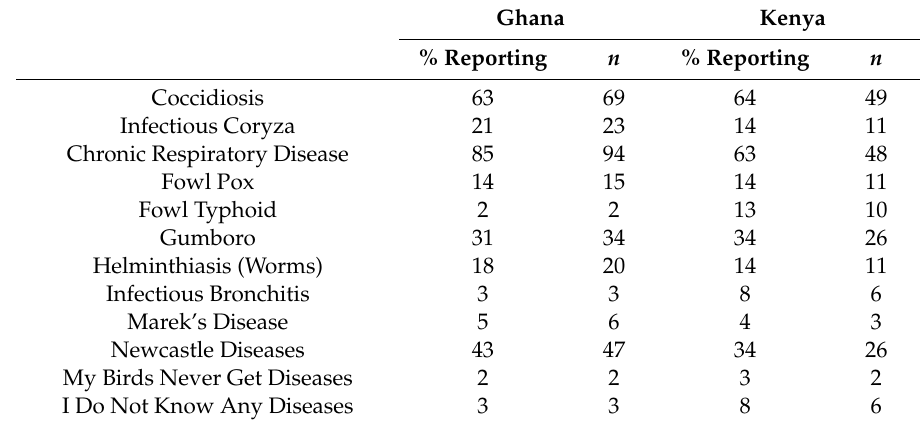
Table 4. Layer diseases reported. Data first reported in Caudell et al. 2020 [22]. Ghana n = 110. Kenya, n = 76. All percentages are rounded up to whole